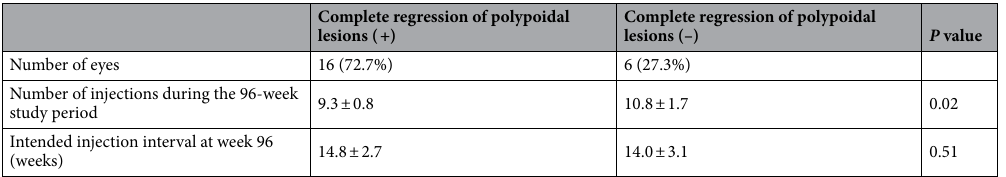
Table 2. Comparison between eyes with and without complete regression of polypoidal lesions after the loading phase treatment.